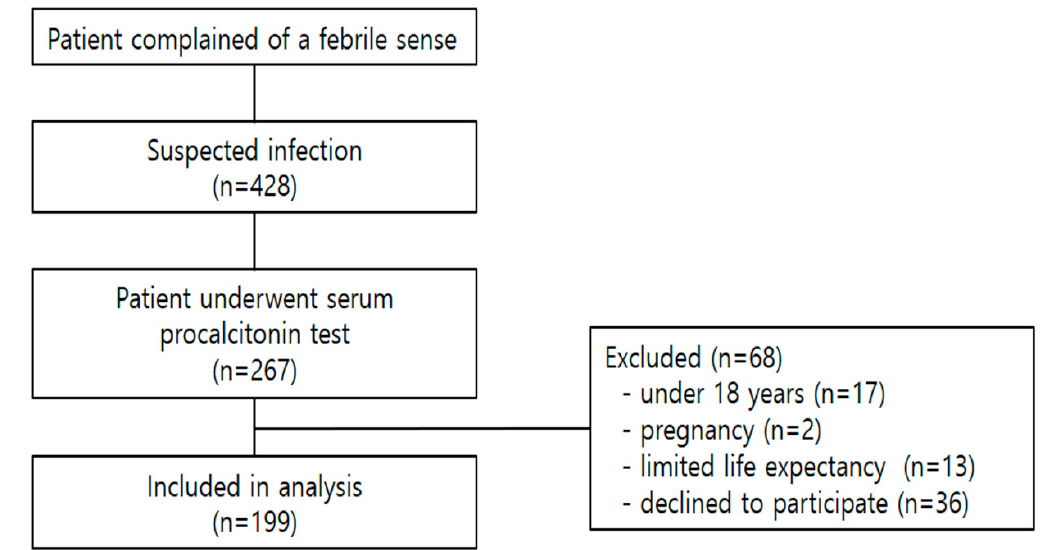
Figure 1. Flow chart of patient recruitment 81